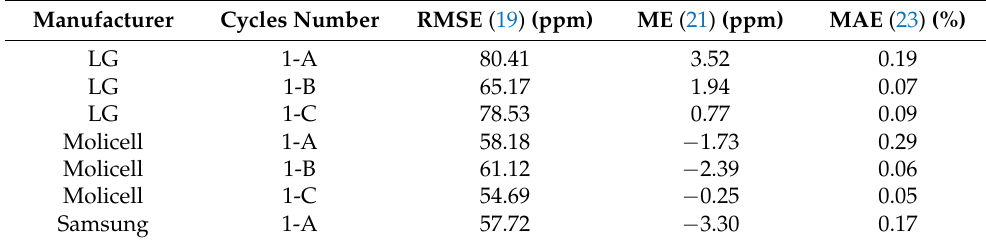
Table 6. Error comparison obtained with the new cell. Voltage V B error estimation.